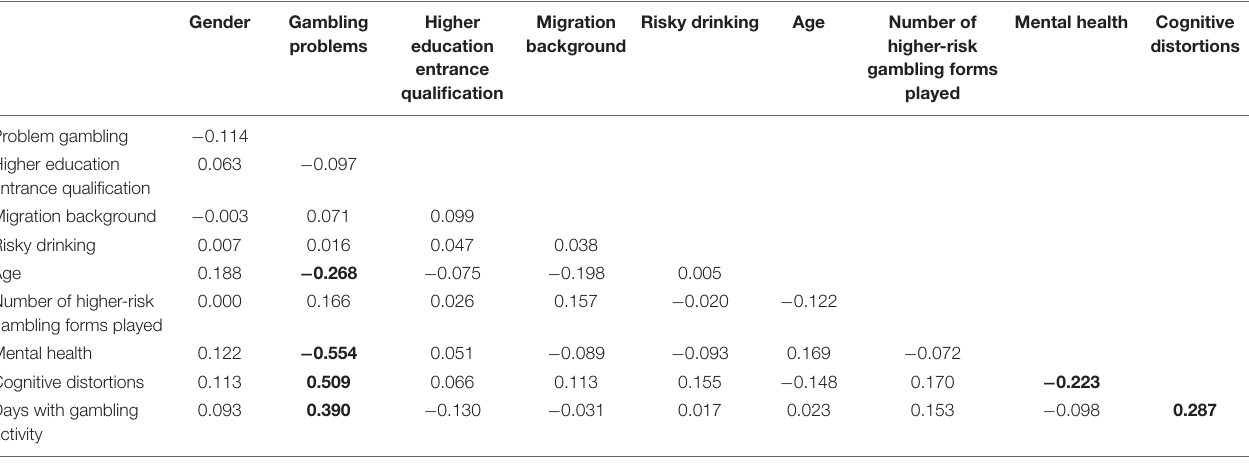
TABLE 3 | Correlations of parameters.